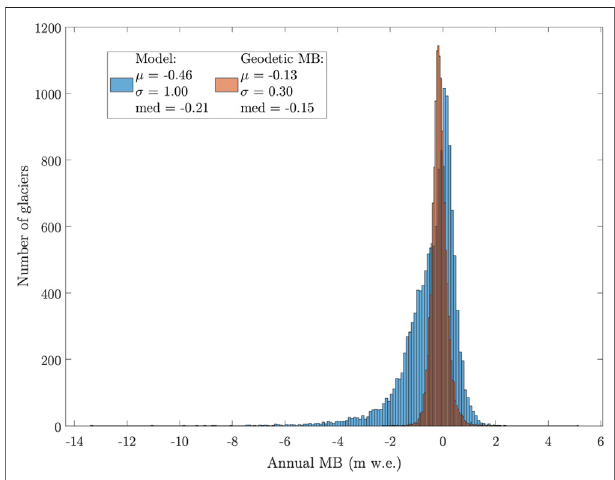
FIGURE 7 | A histogram comparison of modeled annual average mass balancevaluesandgeodeticonesfromSheanetal.(2020)forallglaciersinthe Upper Indus Basin, excluding the 323 used to calibrate the precipitation correction factors. Basic comparative statistics are displayed in the